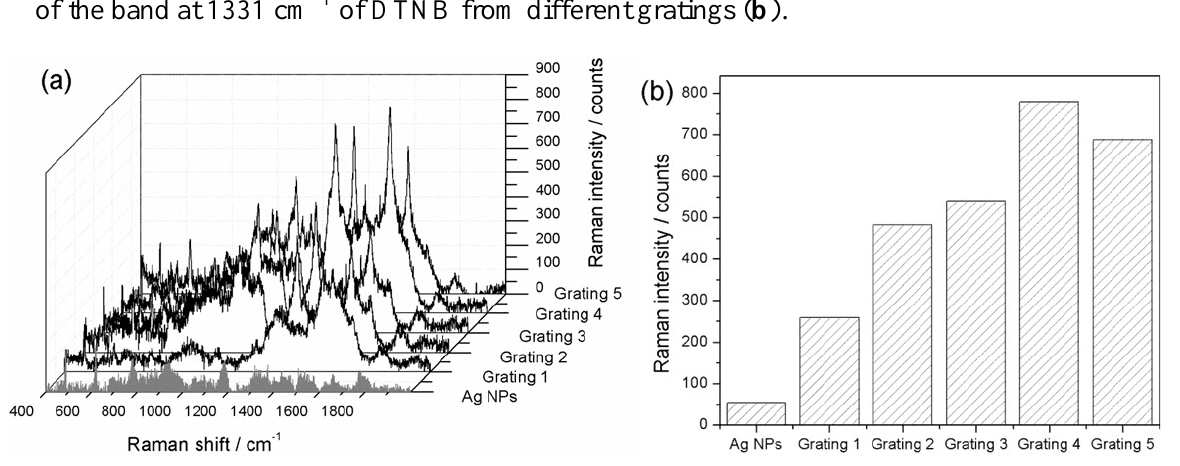
Figure 7. SERS performance of 1 µM DTNB on different gratings ( a ) and Raman intensities of the band at 1331 cm −1 of DTNB from different gratings ( b